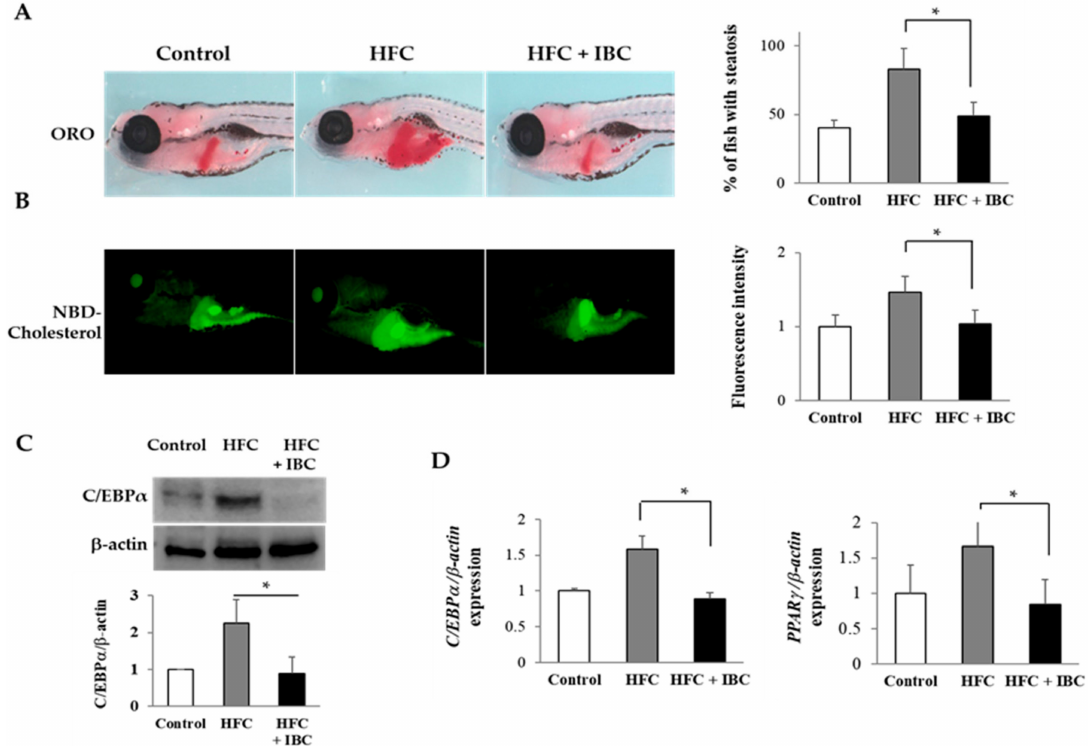
Figure 6. The anti-obesity effect of IBC in high fat cholesterol (HFC)-diet zebrafish. ( A ) Lateral view of 10 dpf larvae staining with ORO. Hepatic lipid accumulation was detected from HFC, and significant reduction of ORO staining was present in the liver with 100 nM IBC treatment ( n = 75 each, * p < 0.01); ( B ) Representative images of live 10 dpf larvae following ingestion of NBD cholesterol (green-colored). Larvae with HFC showed high intensity in the gall bladder and intestine whereas larvae with the high fat cholesterol and 100 nM IBC treatment had reduced metabolism of NBD-cholesterol ( n = 45 each, * p < 0.001); ( C ) Zebrafish total proteins were analyzed for C/EBP α expression. Data represent the mean ± SEM from 3 experiments ( n = 30 each, * p < 0.01); and ( D ) Zebrafish total RNA was analyzed for C/EBP α and PPAR γ expression. Data represent the mean ± SEM from 3 experiments ( n = 30 each, * p < 0.05). Control, normal diet fed larvae; HFC, high fat cholesterol fed larvae; HFC + IBC, high fat cholesterol fed larvae with 100 nM IBC